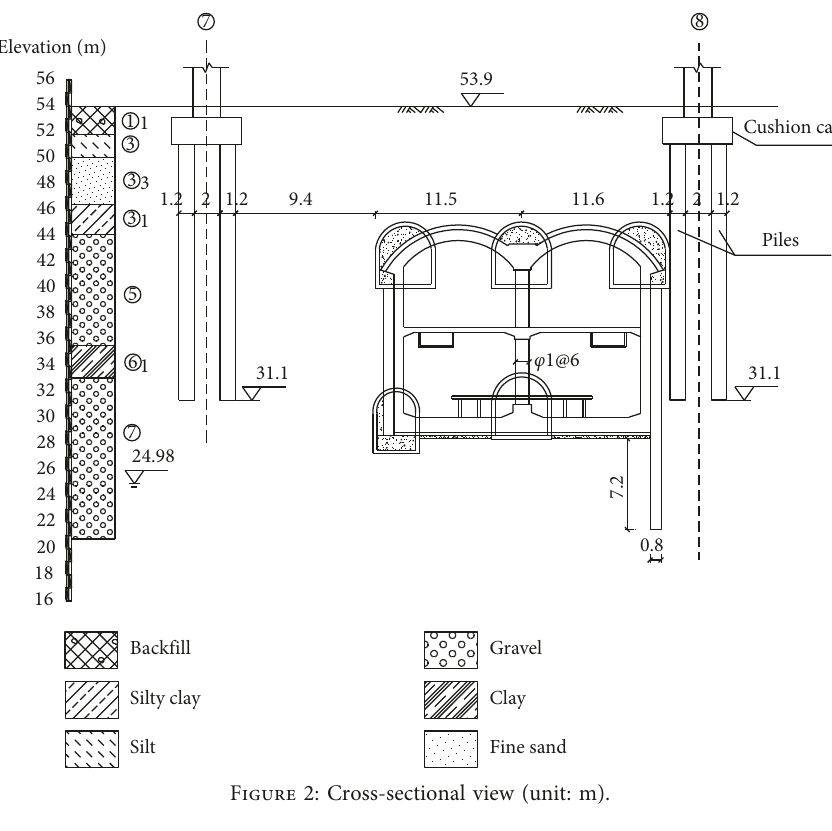
Figure 2: Cross-sectional view (unit: m).